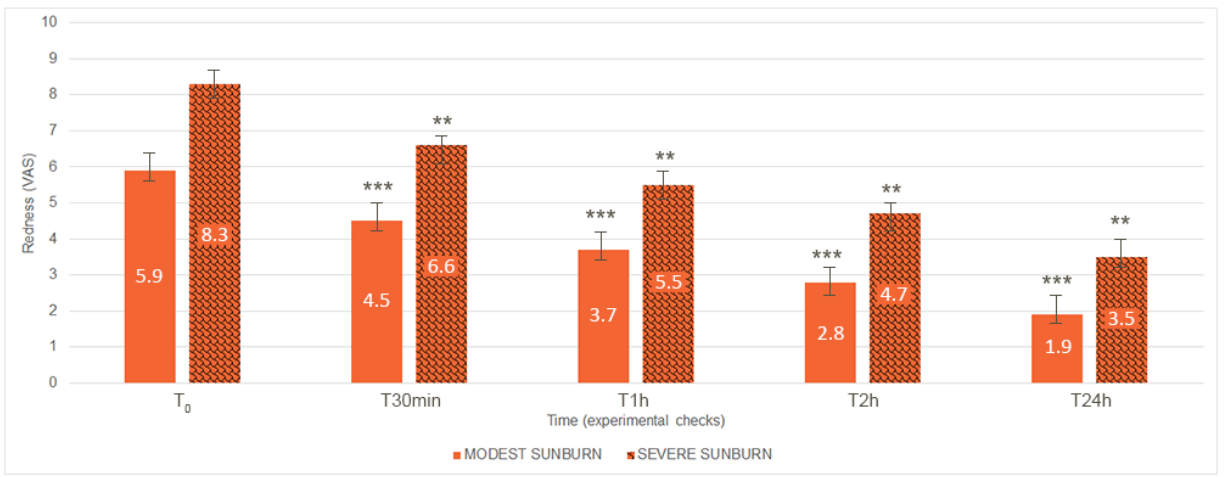
Figure 5. Evaluation of redness after modest and severe sunburn (VAS score) after application of FC 16419 (Data are reported as mean ± SEM). Asterisks in the graph report the intra-group (vs. T 0 ) statistical analysis. Legend (significance): *** p < 0.001; ** p < 0.01.